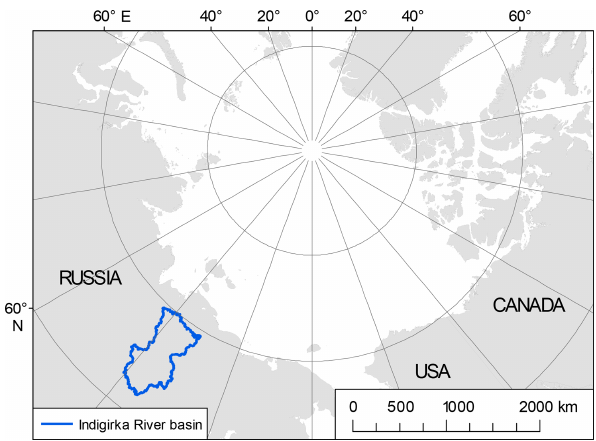
Figure 1. Geographical location of the Indigirka River basin.